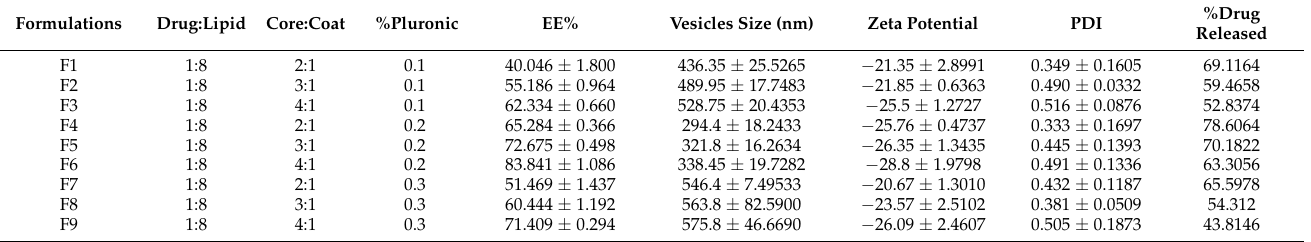
Table 2. The composition of different formulations of QTF loaded lipospheres with their responses.